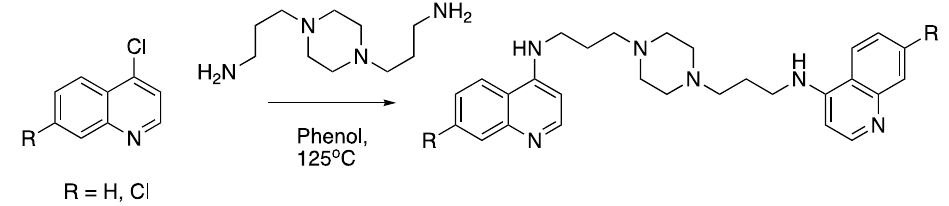
Figure 4. Synthesis of compounds 5 and 7.